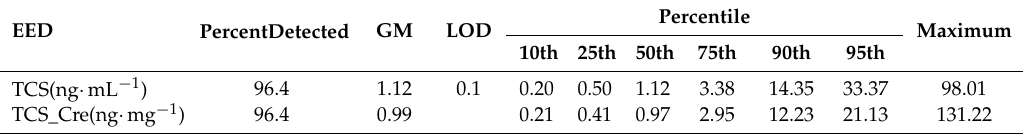
Table 2. Distribution of urinary triclosan (TCS) concentration in the present study.